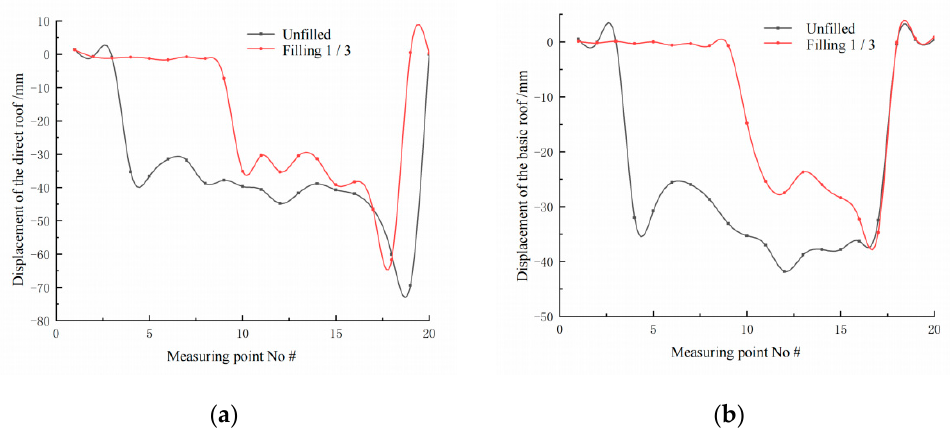
Figure 13. Vertical displacement of the roof. This figure shows the displacement of the main roof in different measuring points of the immediate roof and main roof. ( a ) Immediate roof; ( b ) Main roof.